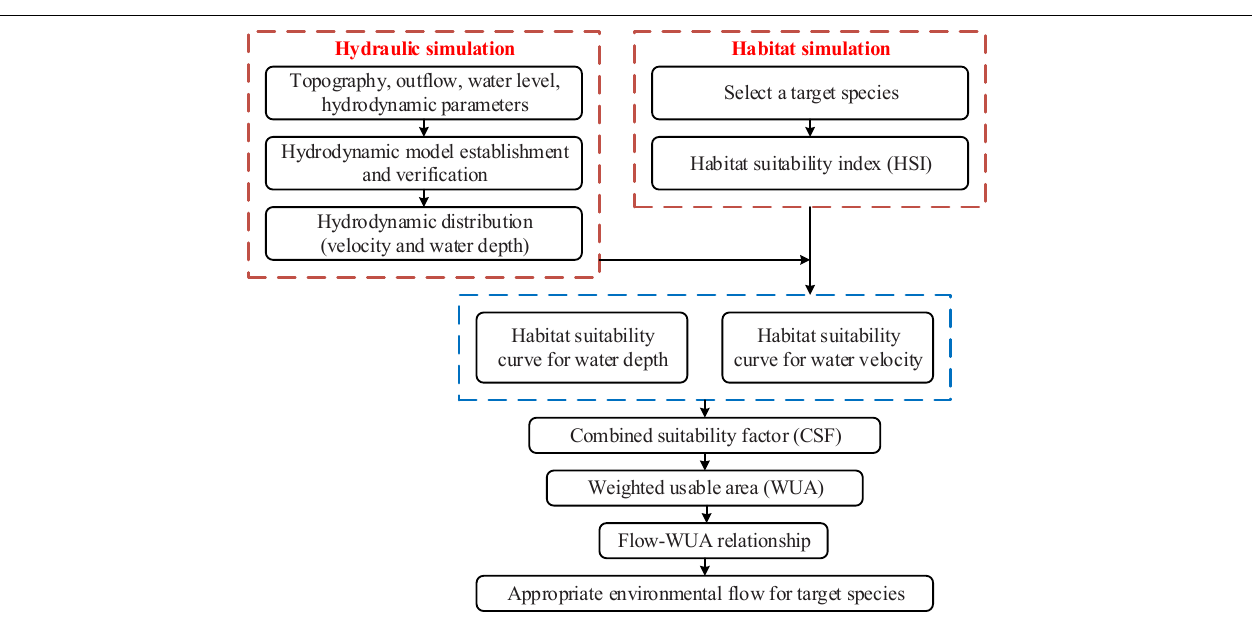
FIGURE 4 | Comparison of observed and simulated velocity and water level. (A) Water level at the two hydrological stations. (B) Velocity at the two hydrological stations.